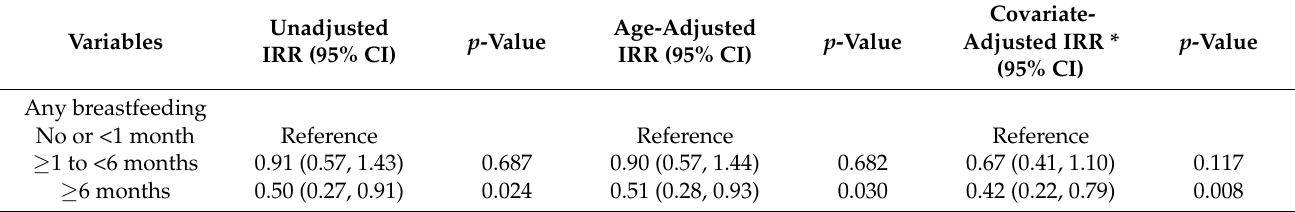
Table 2. Association between breastfeeding and development of dysglycemia